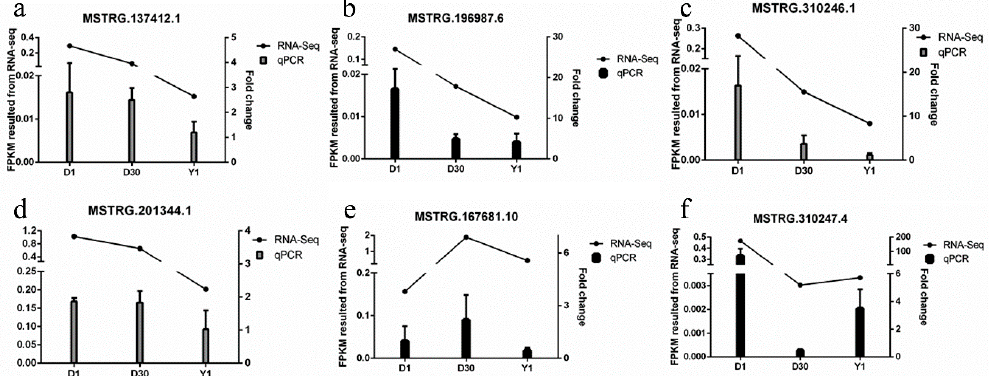
Figure 5. Validation of six differentially expressed lncRNAs (( a ), MSTRG.137412.1; ( b ), MSTRG.196987.6; ( c ), MSTRG.310246.1; ( d ), MSTRG.201344.1; ( e ), MSTRG.167681.10; ( f ), MSTRG.310247.4) by qPCR. Left y axis (line chart) shows the fragments per kb per million reads